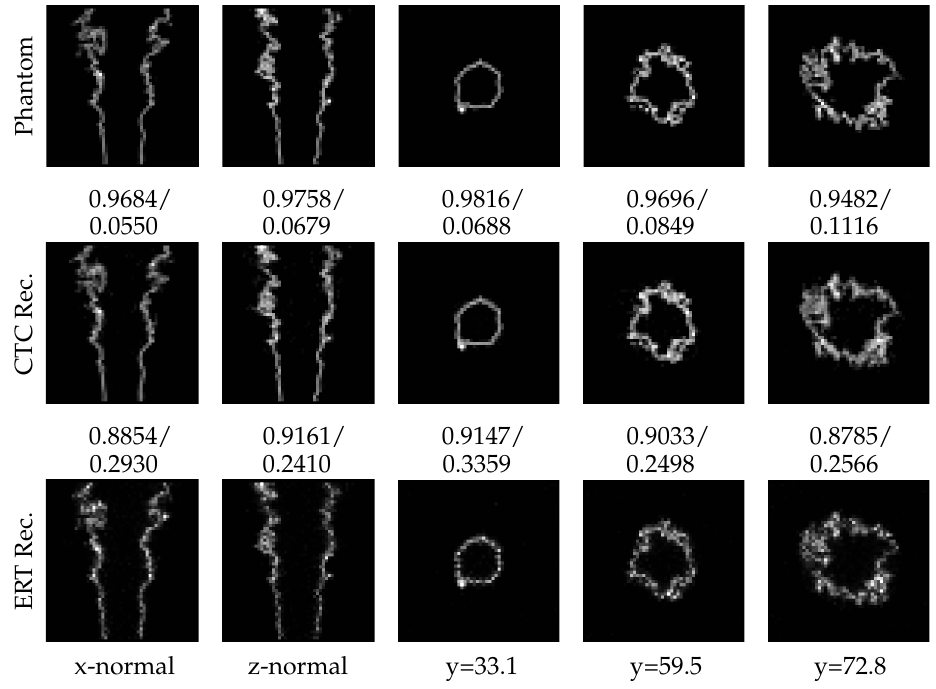
Figure 11. Slices normal to each spatial axis and height above burner exit (in mm), the correlation/normalized Manhattan distance to the phantom of each pair of slices is displayed between the